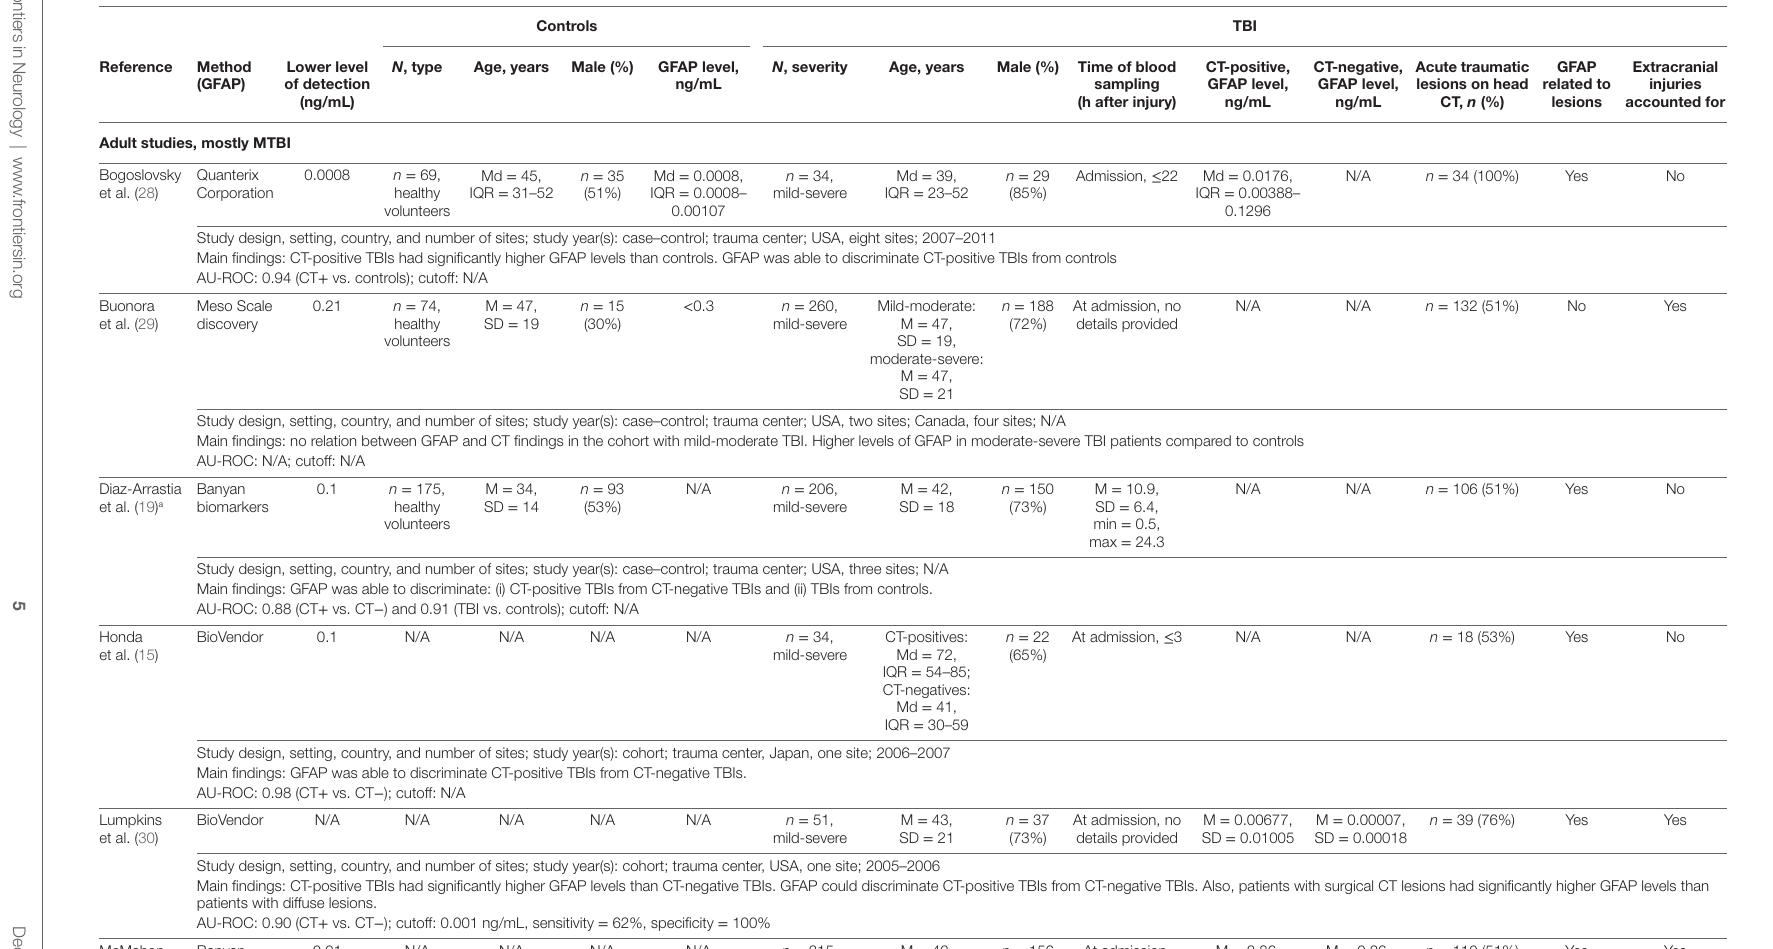
Study design, setting, country, and number of sites; study year(s): cohort; trauma center, USA, one site; N/A Main findings: CT-positive TBIs had significantly higher GFAP levels than CT-negative TBIs. GFAP could discriminate CT-positive TBIs from CT-negative TBIs.